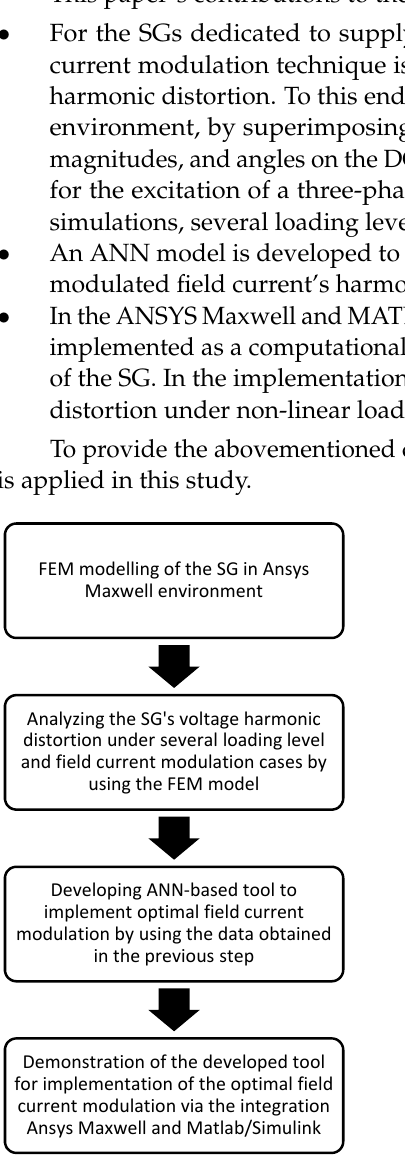
Figure 1. Methodology applied in this study.